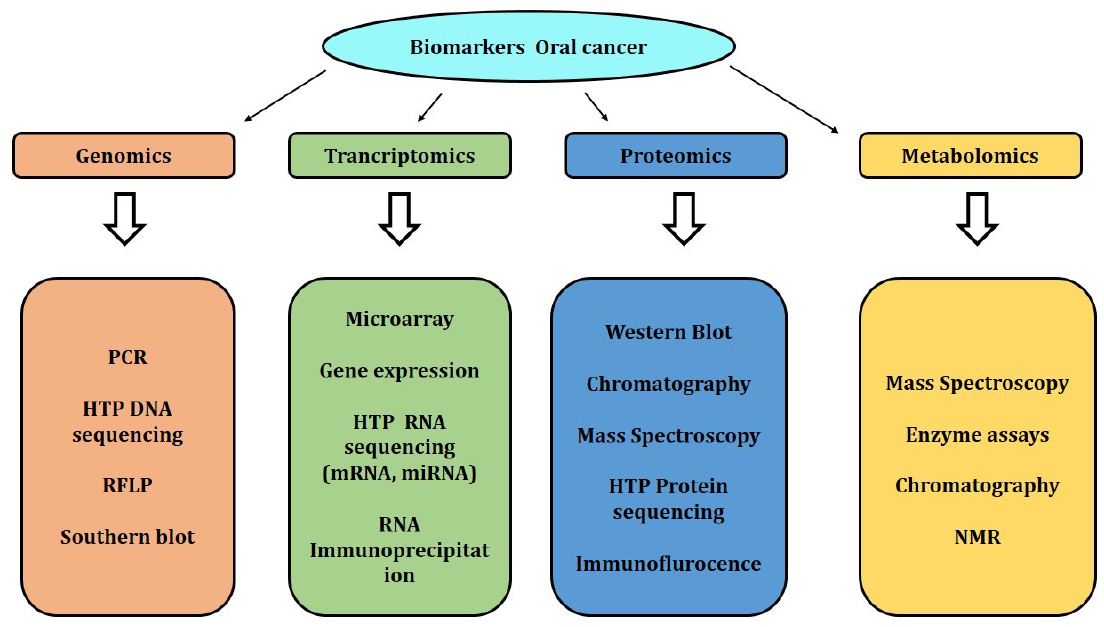
Figure 1. Various molecular methods involved in the detection of biomarkers. Table 2. Biomarkers associated with the data source and technologies used to identify oral cancer and OSCC.